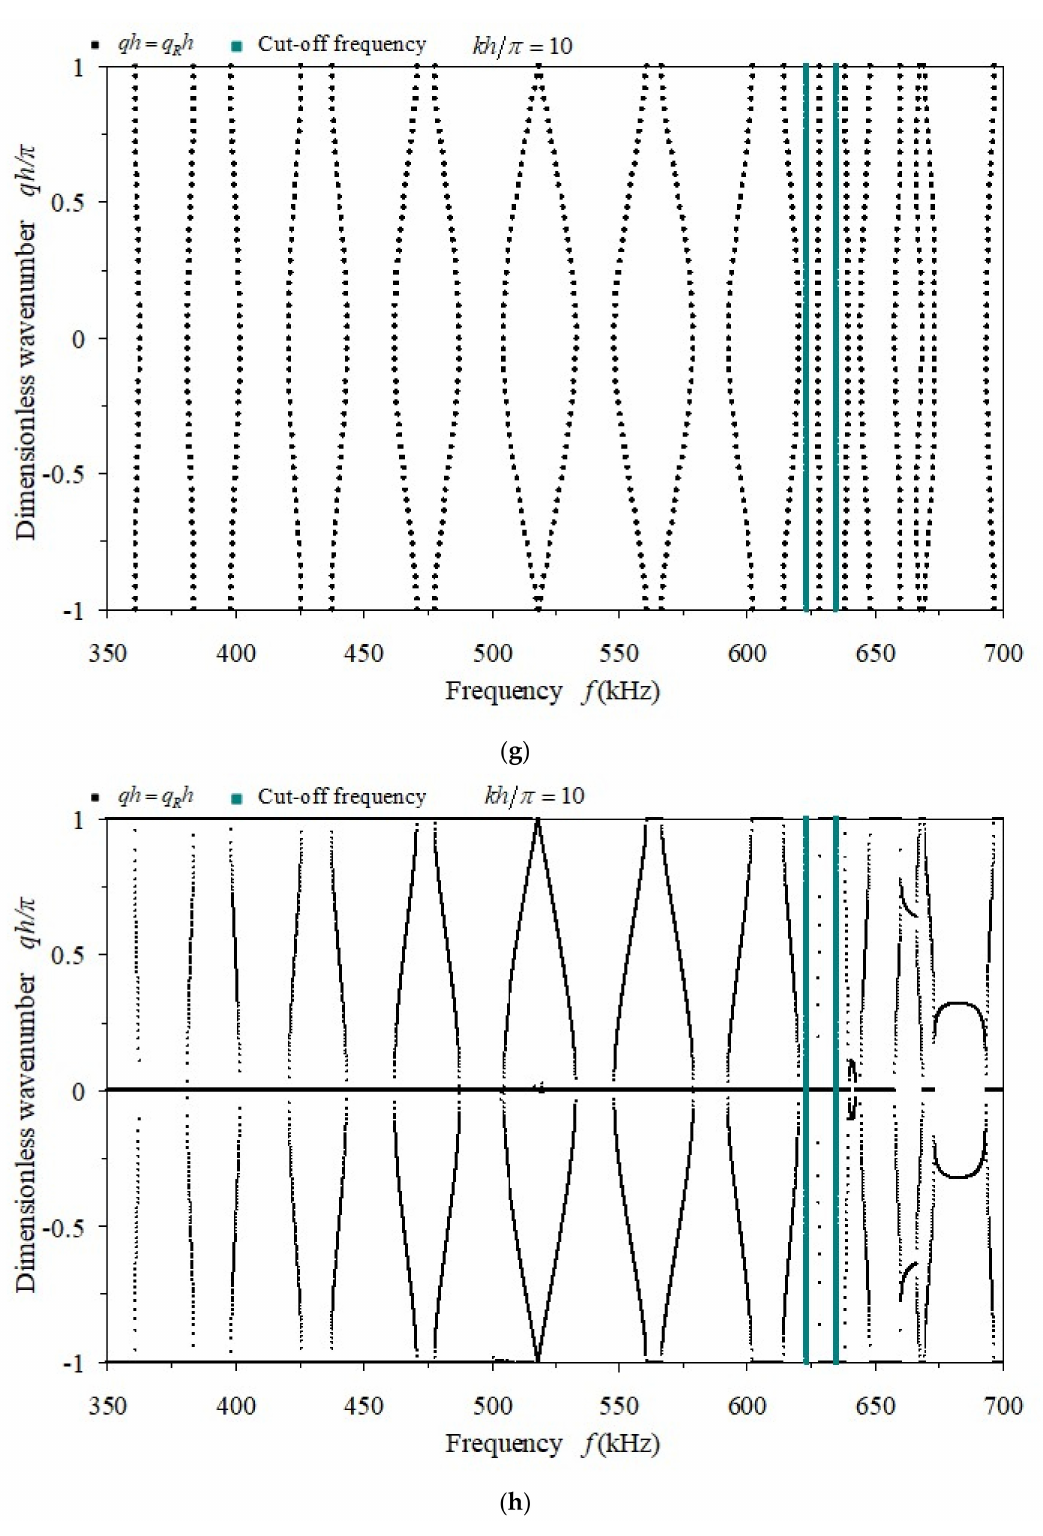
Figure 3. Comparison of the phase constant spectra by the MRRM and the MTM to prove the numerical stability of MRRM. The sub–figures ( a – d ) are results for kh / π = 5, while the sub–figures ( e – h ) are results for kh / π = 10; the results ( a , c , e , g ) are by the MRRM, while the results ( b , d , f , h ) are by the